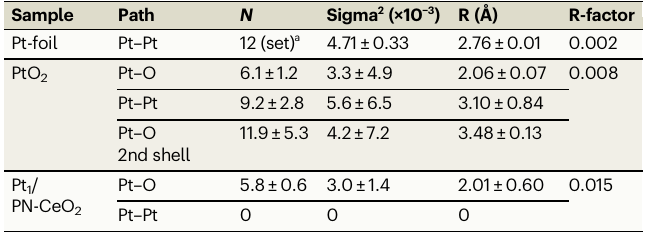
Table 1 | FT-EXAFS spectra and the fi tting curves (without phase correction)